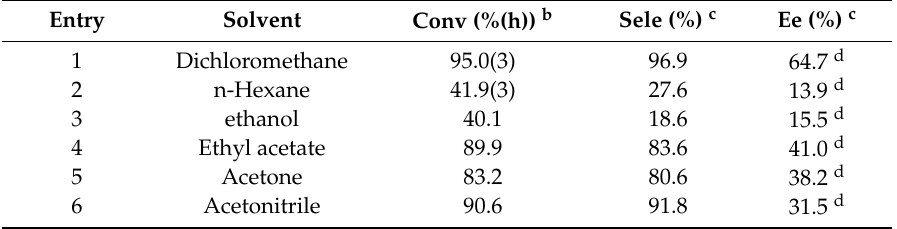
Table 3. The results of asymmetric epoxidation of styrene in different solvents over catalyst 3 a .